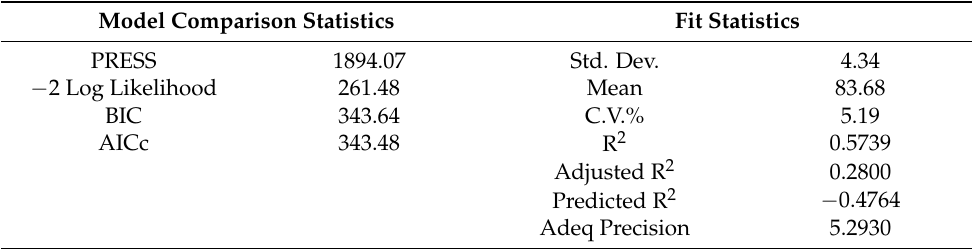
Table 4. Model comparison and fit statistics for Pb